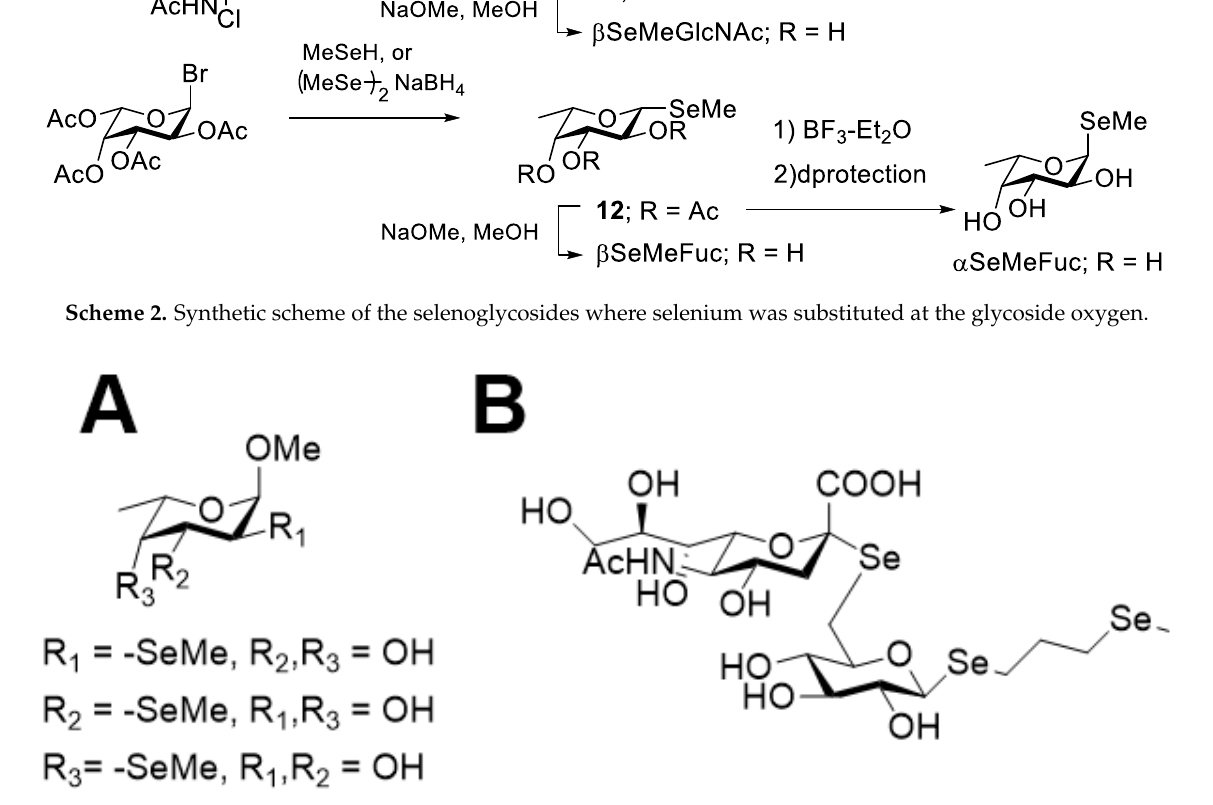
Figure 4. Fucose derivatives with selenomethyl substitutions at the 2, 3, or 4 hydroxy group ( A ) and sialylglucose derivative with three selenomethyl substitutions ( B ).